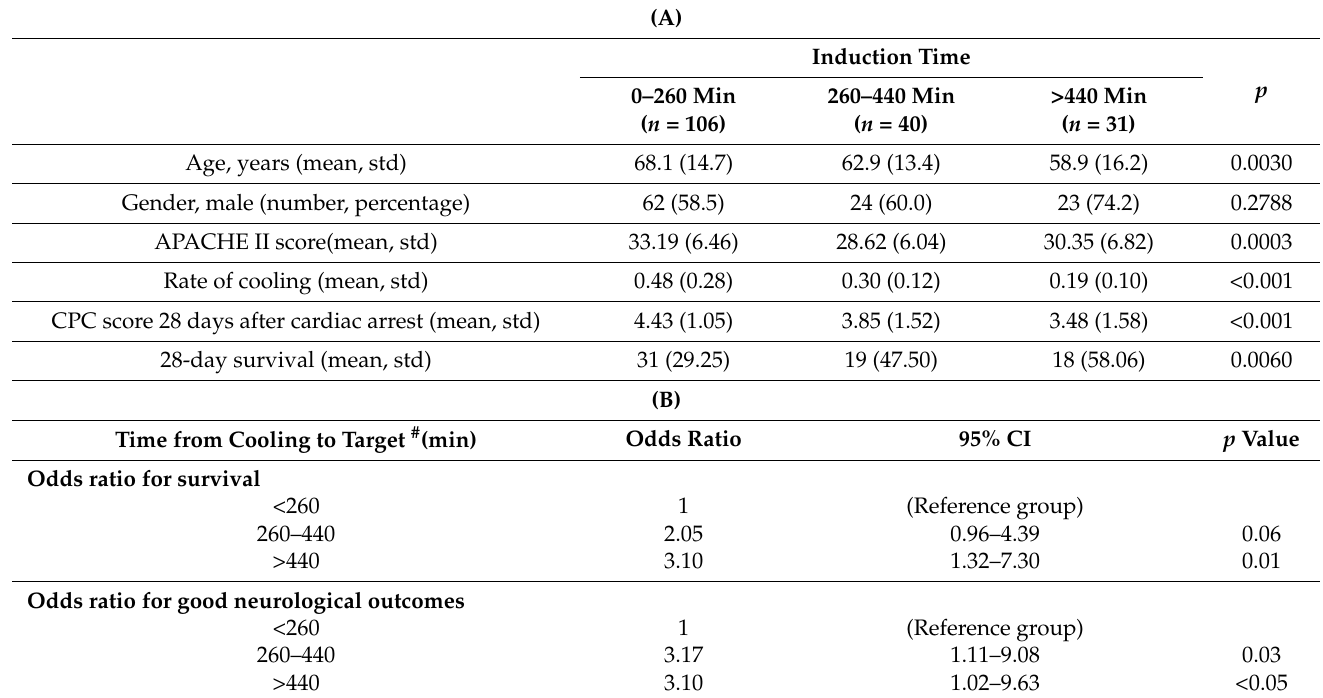
Table 4. ( A ) Comparisons of the three induction time groups. ( B ) Adjusted odds ratios of different induction times for survival and good neurological outcomes.